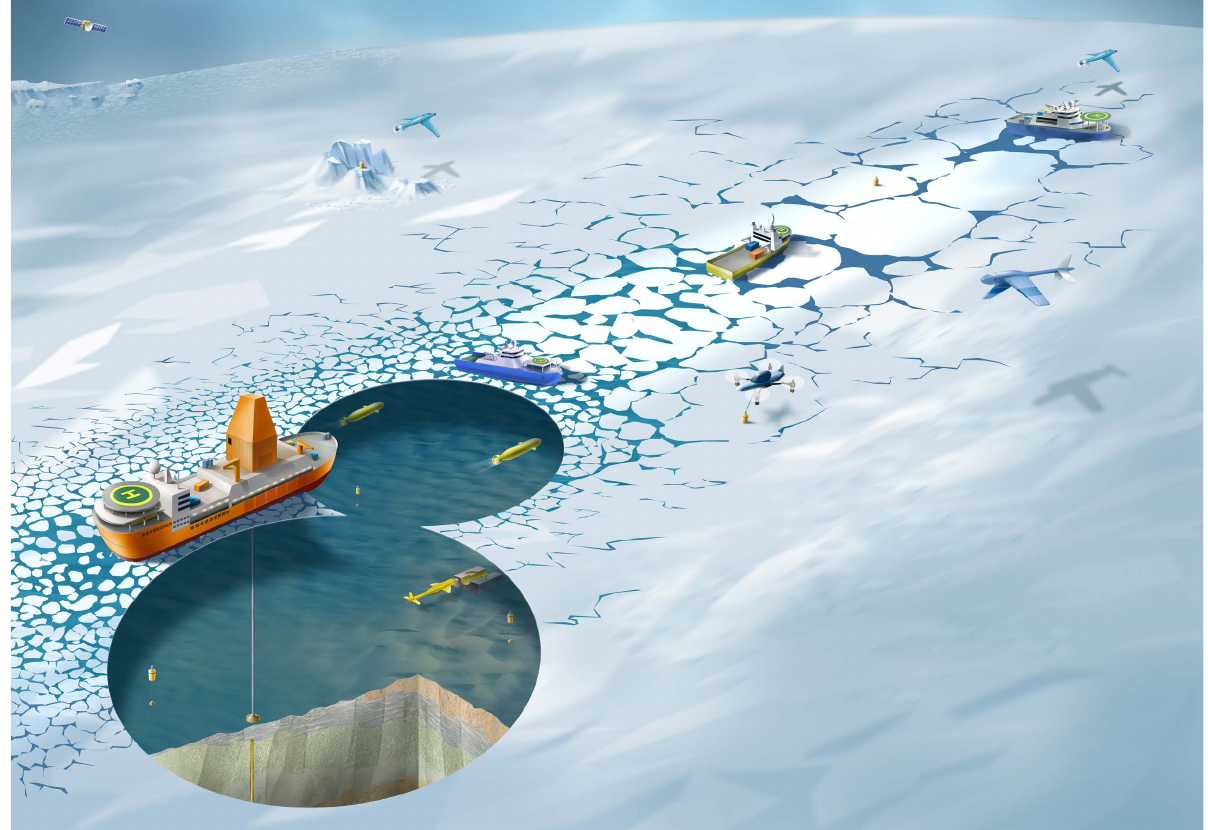
Figure 1: Illustration of a possible future Arctic drilling operation: an Arctic drillship on DP, aided by icebreak- ers and unmanned vehicles. Illustration: Bjarne Stenberg. Copyright: